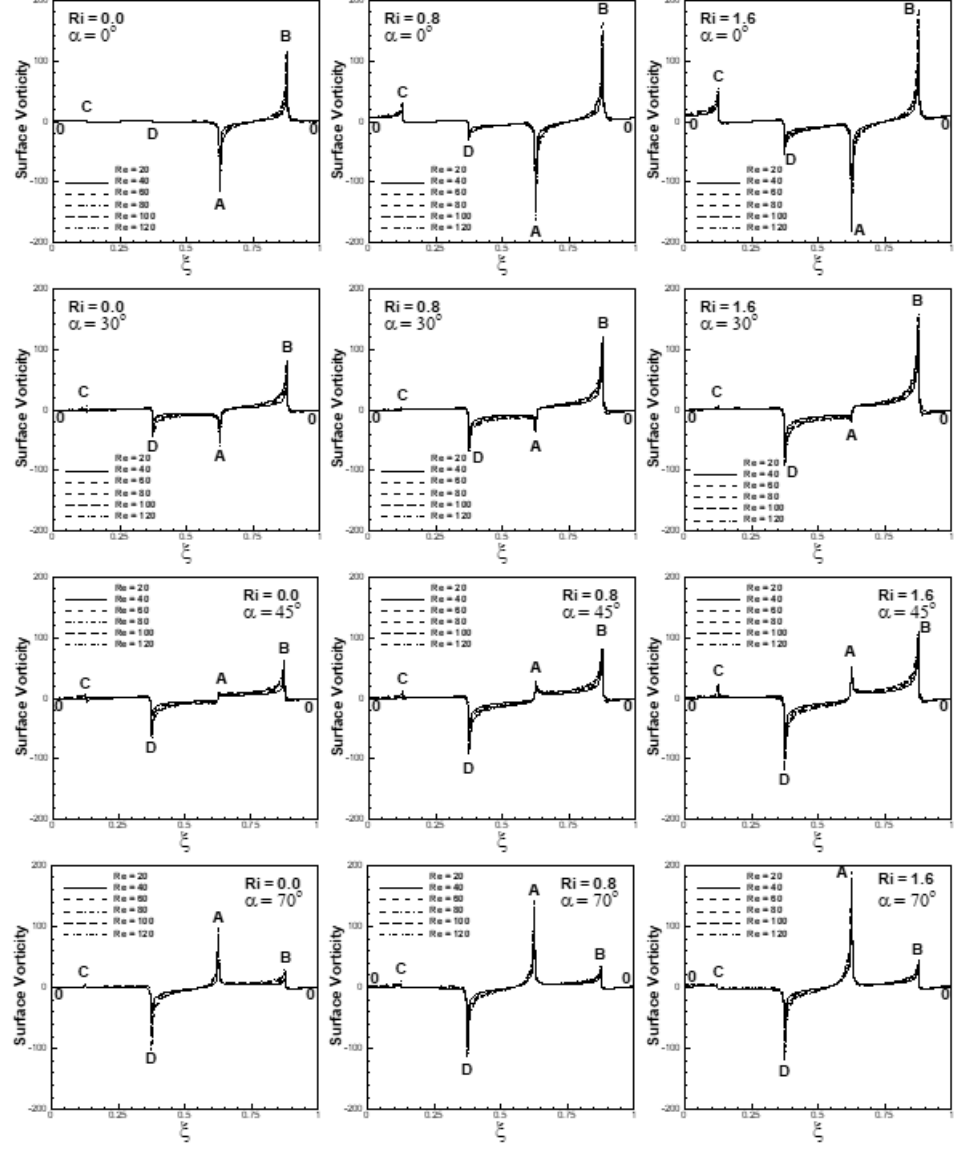
Figure 14. Mean vorticity along the surface of cylinder at 20 ≤ Re ≤ 120, 0 ≤ Ri ≤ 1.6 and 0° ≤ α ≤ 70°.